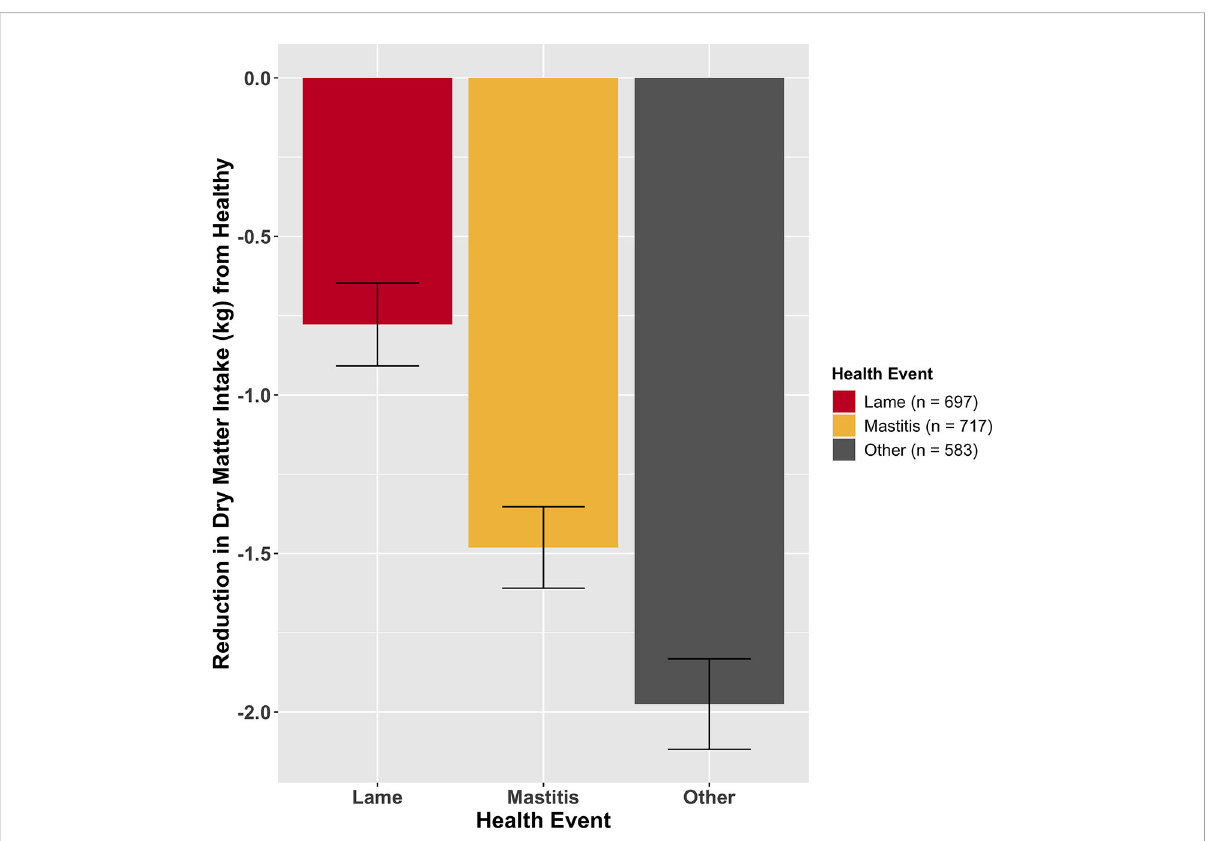
FIGURE 1 Reduction in least squares means of dry matter intake (DMI) for health disorders compared to cows considered healthy when accounting for systematic effects (i.e., contemporary group, days in milk, and parity; Model [3]). All reductions in DMI from healthy were signi fi cant at P< 0.0001. Importantly, the mastitis category only includes mild cases. The other category included disorders with minimal observations, including respiratory illness, injury, and multiple concurrent health